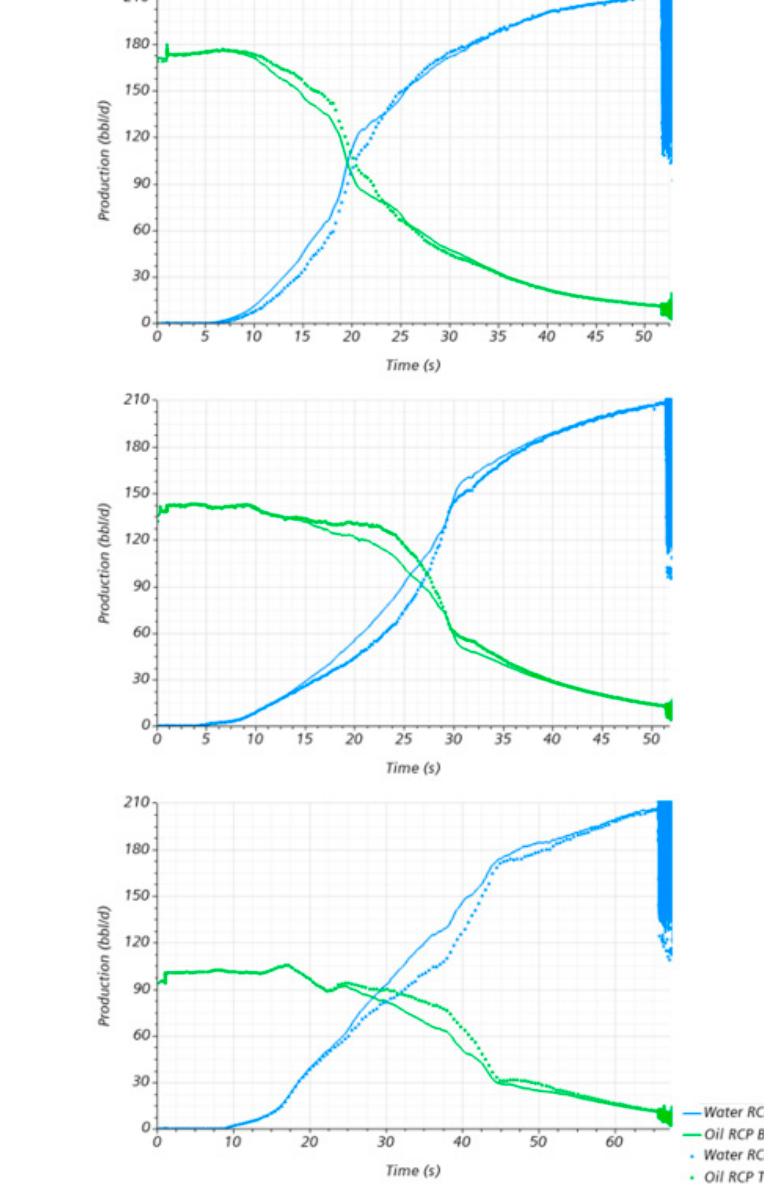
Figure 12. Production profiles obtained for the two RCP valves for the oil viscosity sensitivity analysis: ( a ) µ oil = 0.2, ( b ) µ oil = 0.4, and ( c ) µ oil = 0.8 Pa ·